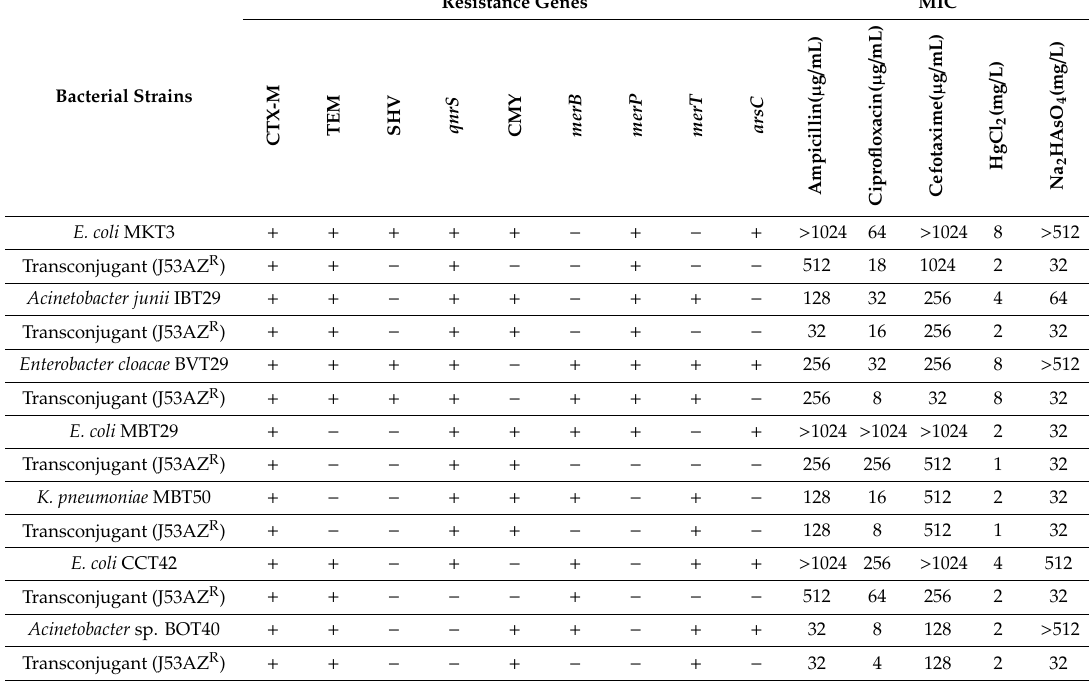
Table 3. Distribution of antibiotics and heavy metal resistance genes among transconjugants and their Minimum inhibitory concentrations